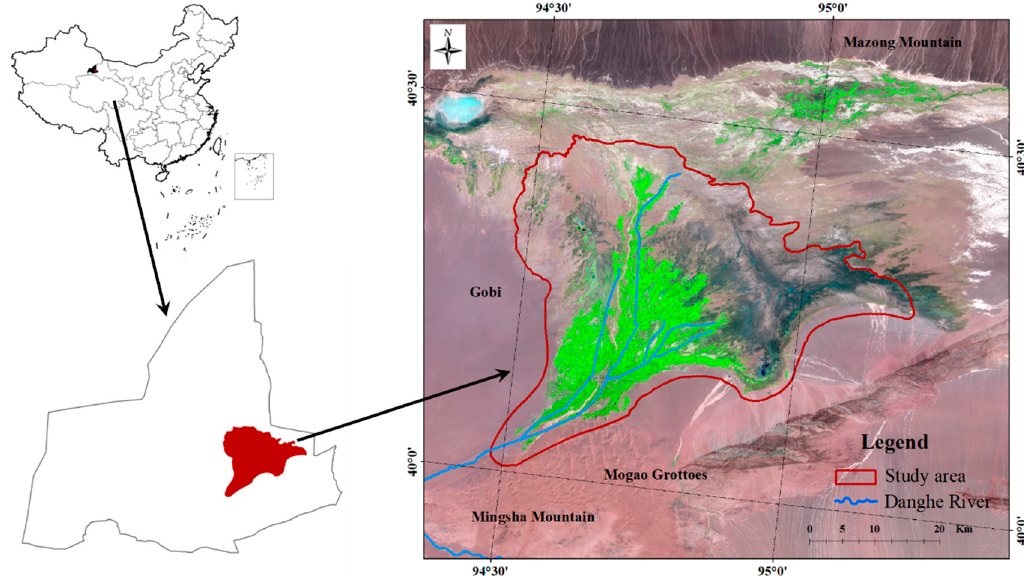
Figure 1. Study area derived by Landsat TM imagery (Bands 5-4-3).